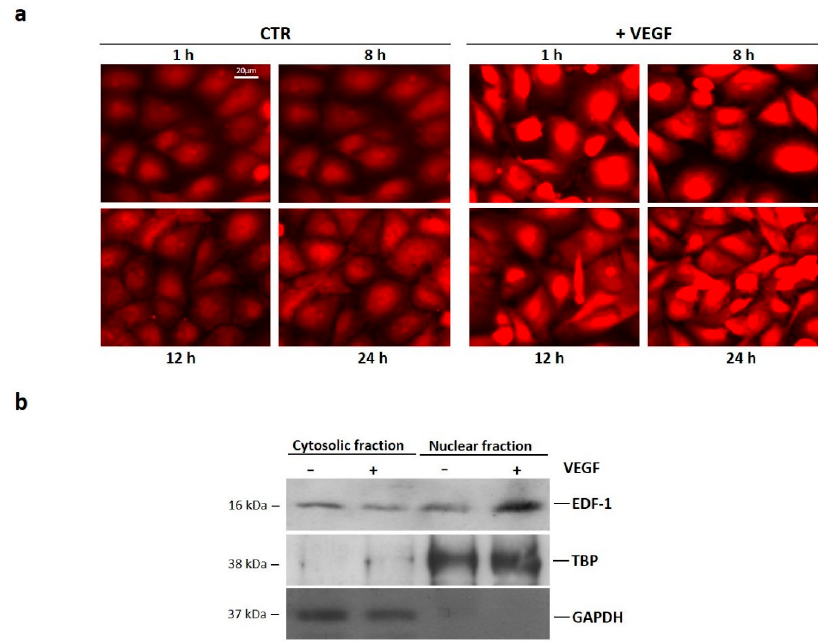
Figure 1. The total amounts of endothelial differentiation-related factor 1 (EDF1) and peroxisome proliferator-activated receptor gamma (PPAR γ ) in cells treated with VEGF. Human umbilical vein endothelial cells (HUVEC) were treated with 50 ng/mL of vascular endothelial growth factor (VEGF) for 0, 8, 12, and 24 h. ( a ) Real-Time PCR was performed on RNA samples. Two different experiments in triplicate were performed; ( b ) cell lysates were analyzed by western blot using antibodies against EDF1, PPAR γ , and actin. A representative blot is shown.